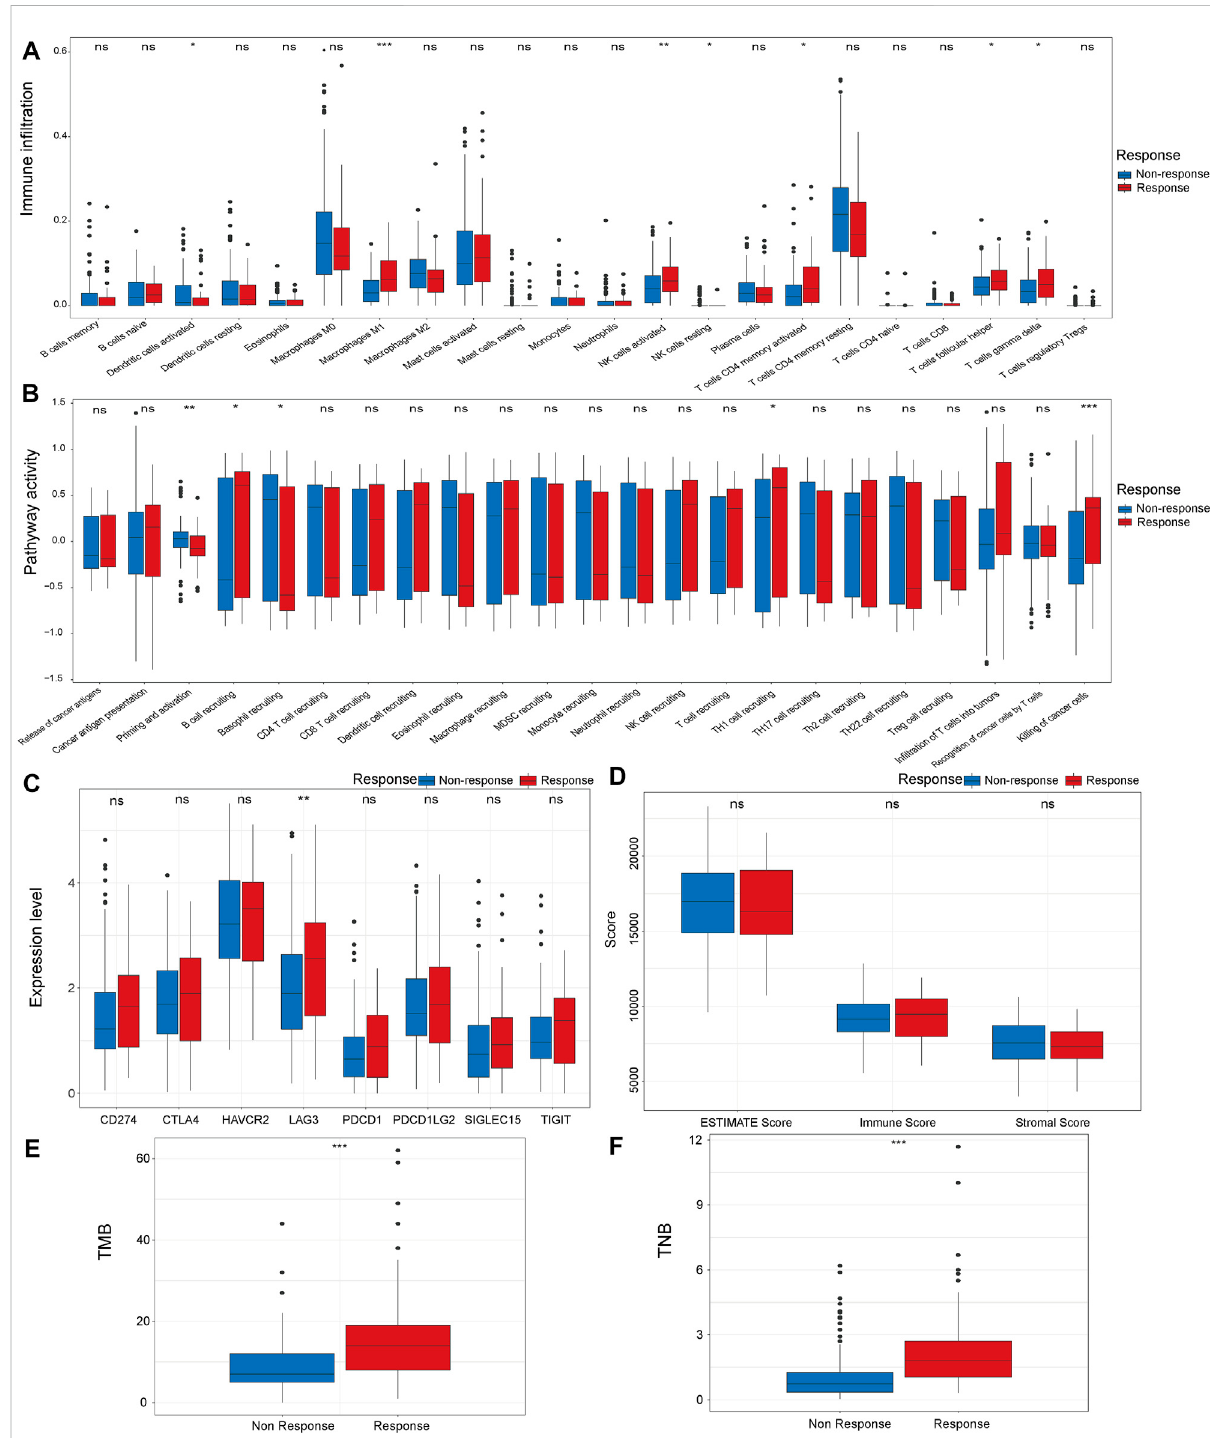
FIGURE 1 Comparison of microenvironment characteristics of theresponse and non-response group in IMvigor210 cohort, The immunein fi ltration level (A) , cancer immune circle related process activity (B) , immune checkpoint expression (C) , ESTIMATE score (D) , TMB (E) and TNB (F) in the response and non-response groups. * p < 0.05, ** p < 0.01, *** p < 0.001. TMB: Tumor mutation burden. TNB: Tumor neoantigen